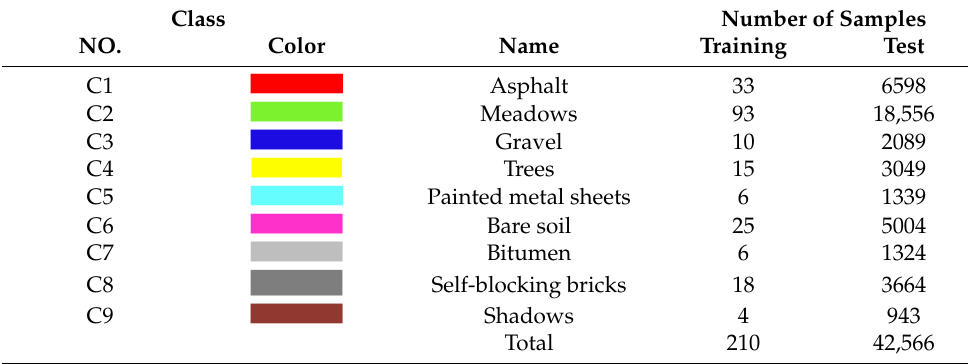
Table 2. Number of training samples and test samples in UP data